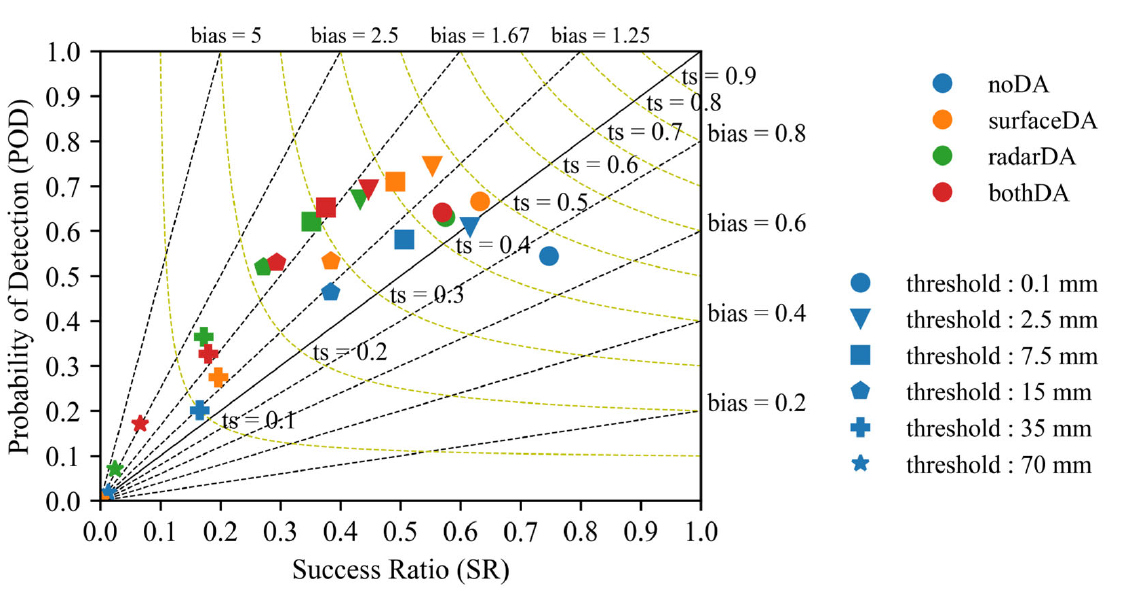
Figure 8. The performance diagram of 6 h (1500 UTC to 2100 UTC 11 July 2014) accumulated precipitation for noDA (blue markers), radarDA (green markers), surfaceDA (orange markers) and bothDA (red markers) experiments. The horizontal coordinates represent the success ratio (SR). The longitudinal coordinates represent the probability of detection (POD). Yellow curves represent the threat score (TS), and the black dashed lines represent the bias score (BIAS). The filled circle, down-pointing triangle, square, pentagon, plus and star makers represent different precipitation thresholds. The score area is the same as the panel area in Figure 7.